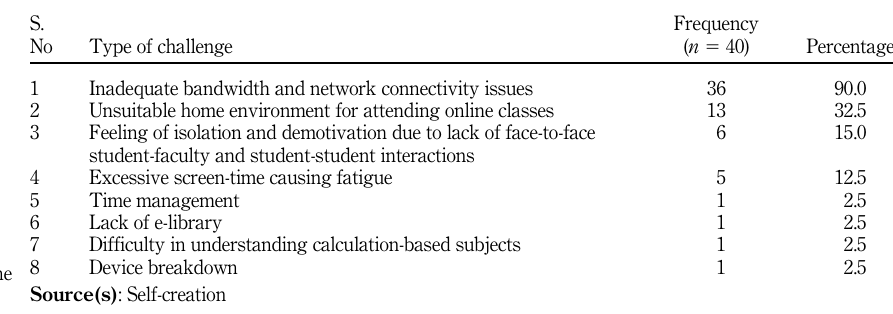
Table 2. Challenges faced by students during online